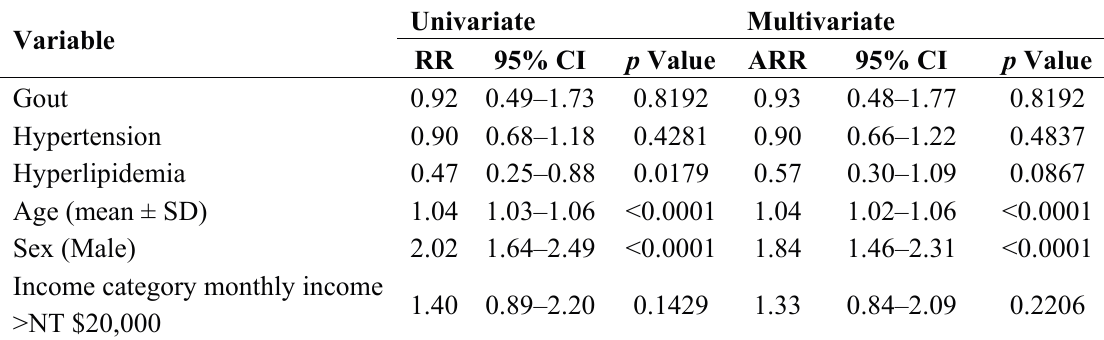
Table 2. Univariate regression and multivariate Cox regression analysis for those >65 years with diabetes with